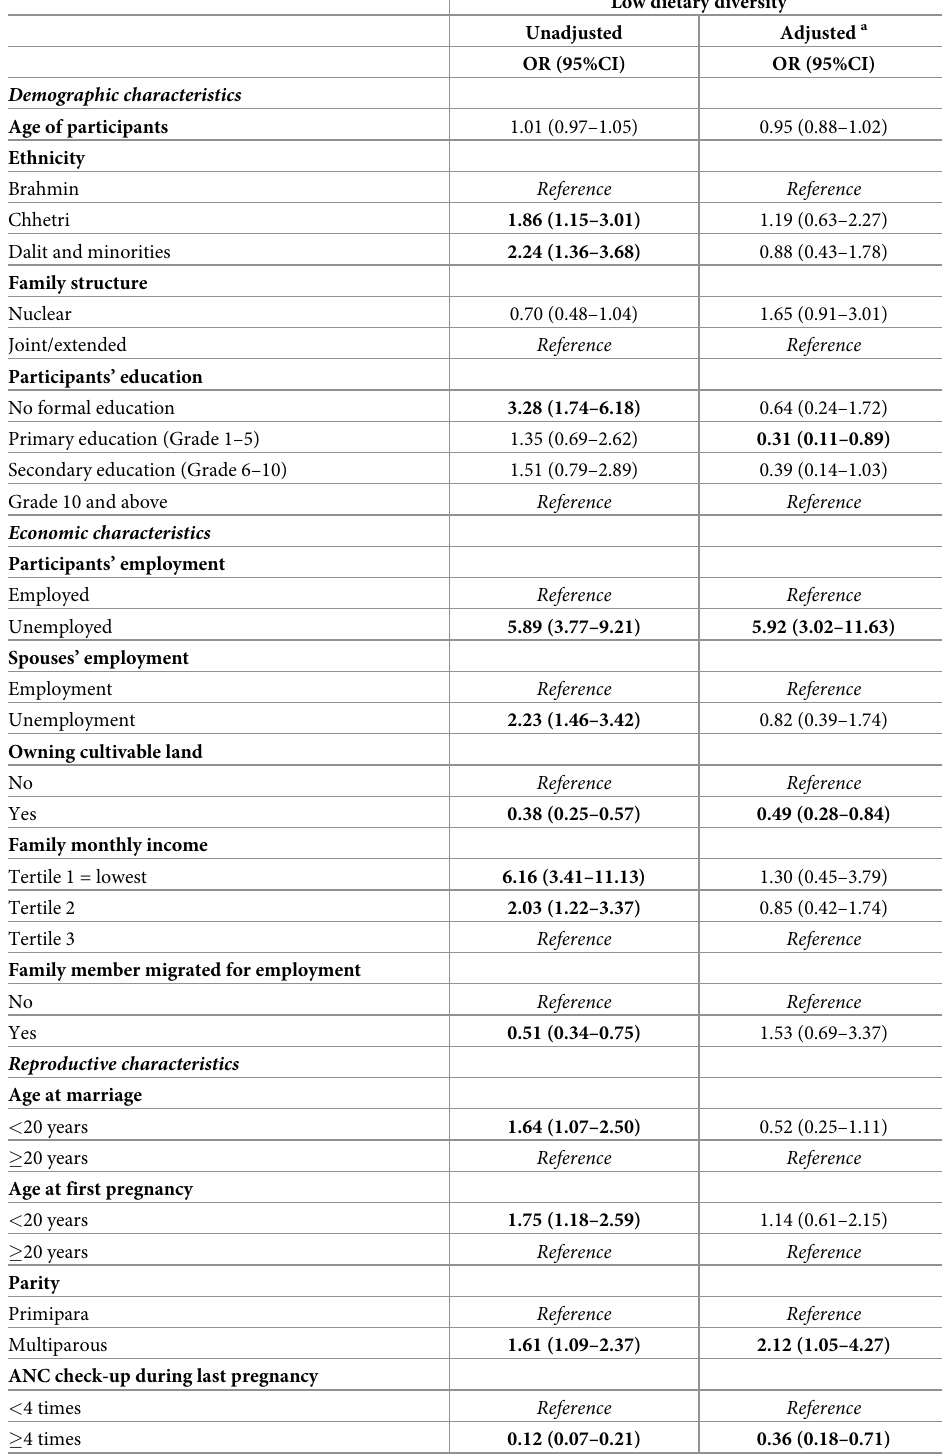
Table 3. Unadjusted and adjusted odds ratios using logistic regression for factors associated with low dietary diversity among lactating mothers in Jaya Prithivi Municipality, Bajhang District, Nepal (n =